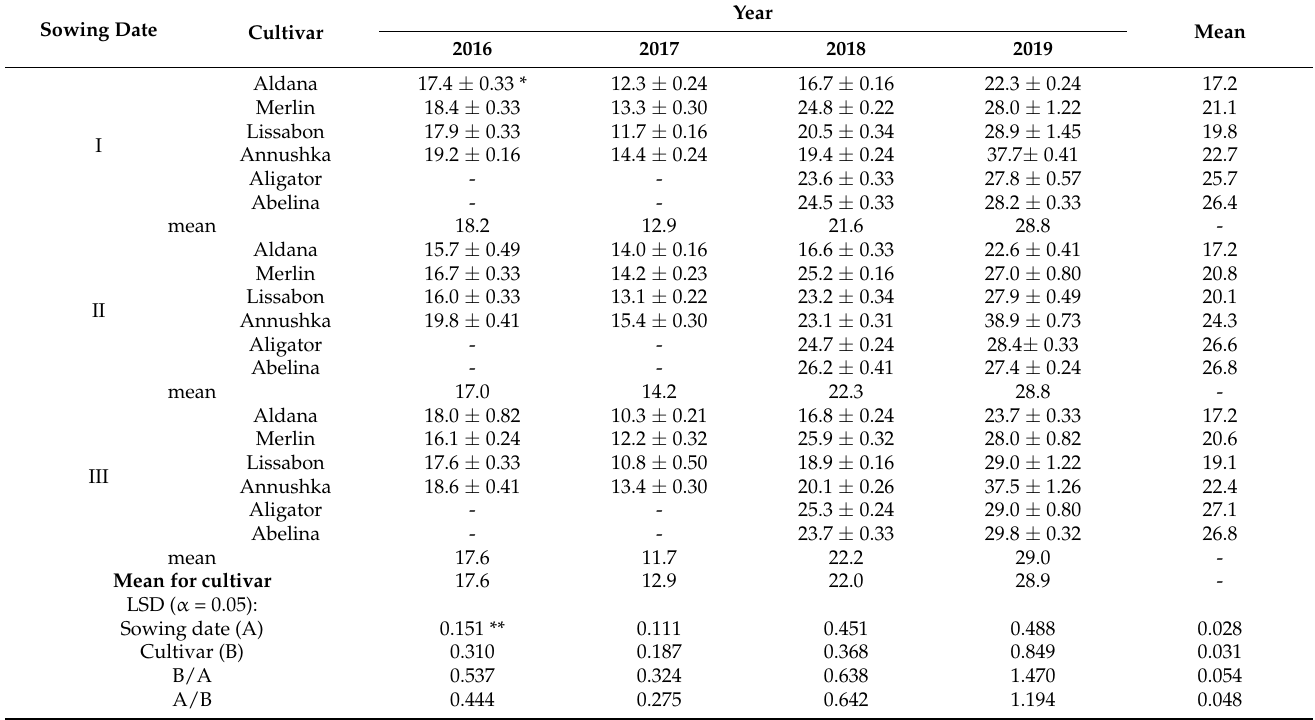
Table 10. Pod number per plant depending on cultivar and sowing date (units).